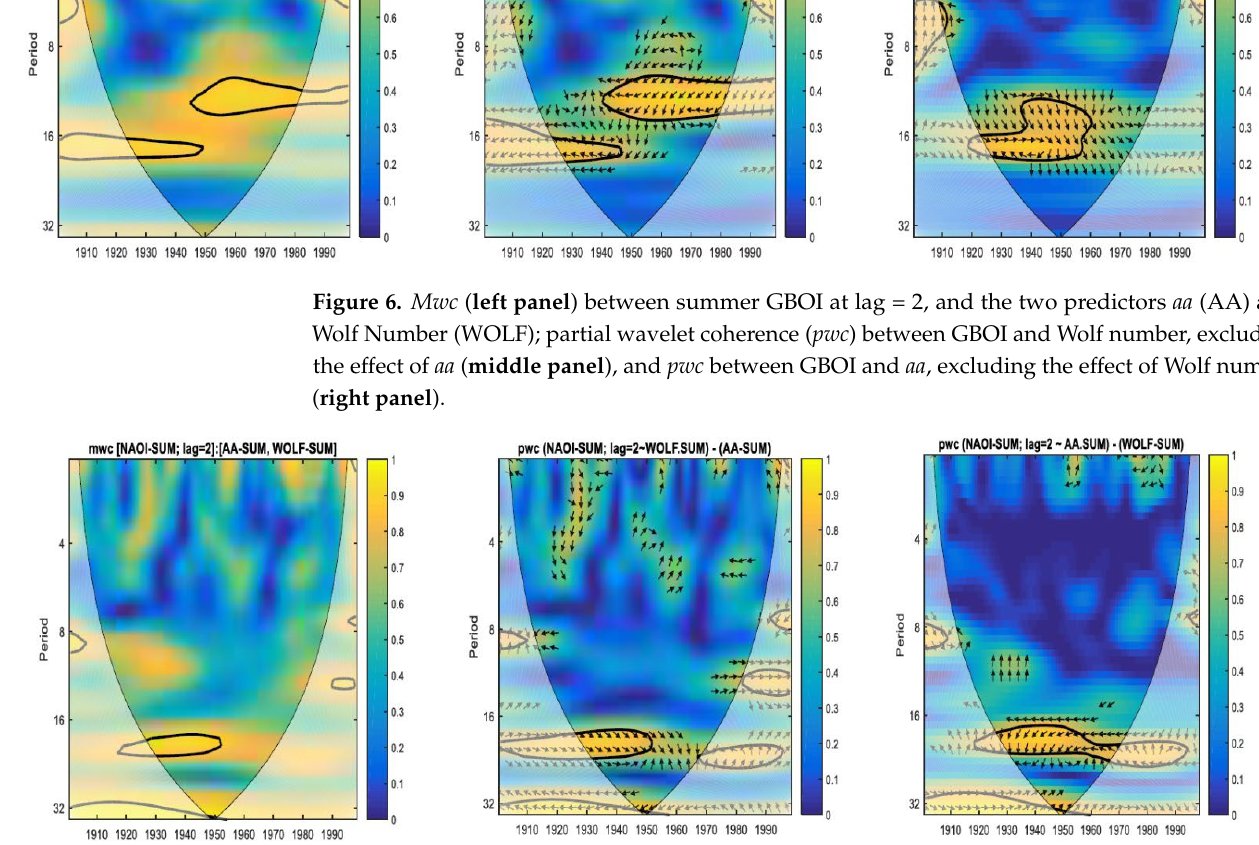
Figure 7. Mwc ( left panel ) between summer NAOI at lag = 2, and the two predictors aa (AA) and Wolf Number (WOLF); partial wavelet coherence ( pwc ) between NAOI and Wolf number, excluding the effect of aa ( middle panel ), and pwc between NAOI and aa , excluding the effect of Wolf number ( right panel ).